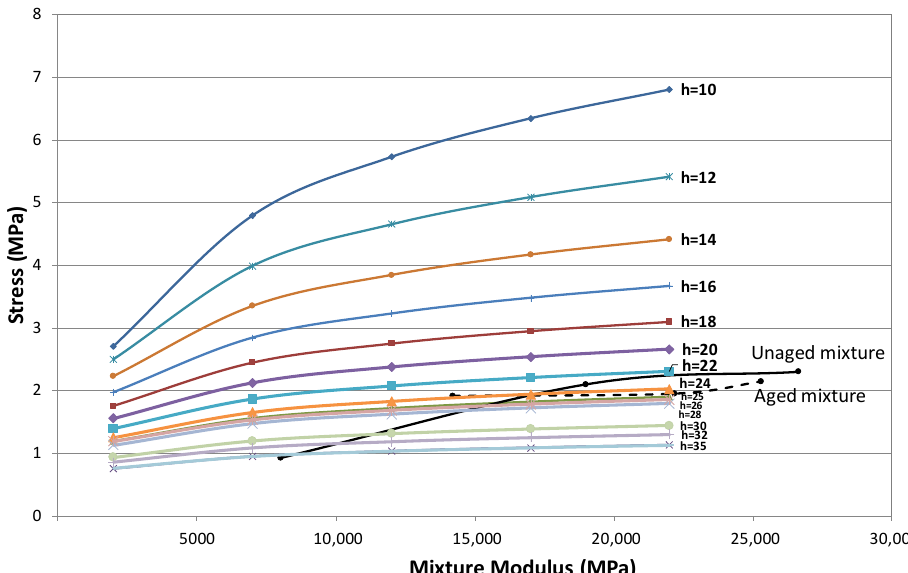
Figure 14. Relationship between the stresses produced in the slab and the resistance of the mixes, for the different slab thicknesses and mixture moduli.